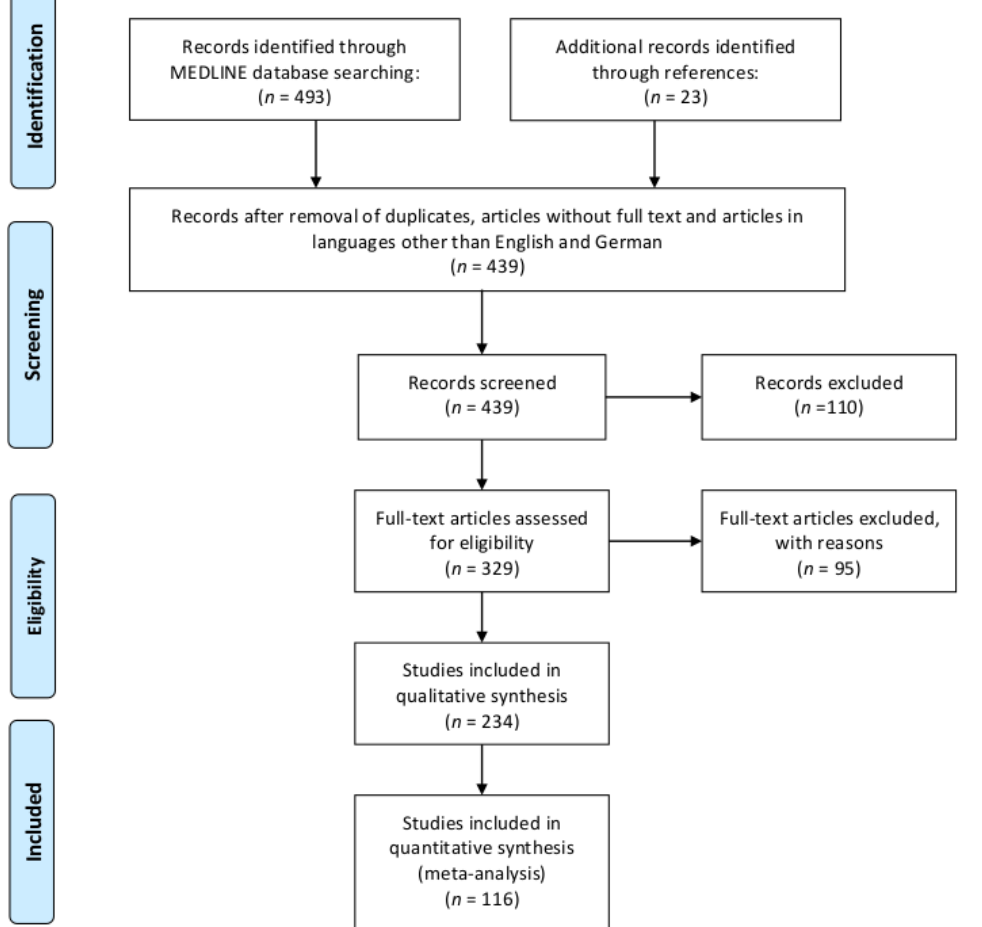
Figure 1. Preferred Reporting Items for Systematic Reviews and Meta-Analyses (PRISMA) flow diagram of the reviewed